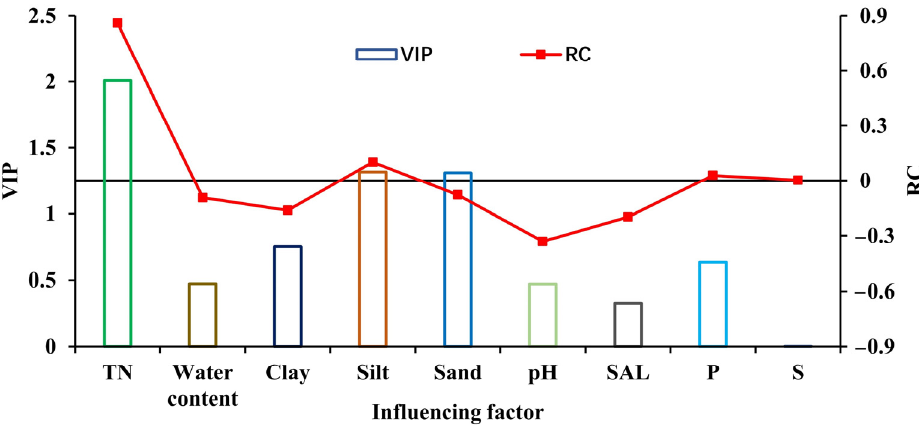
Figure 7. PLSR model of factors influencing the content of soil OC in reclaimed areas.